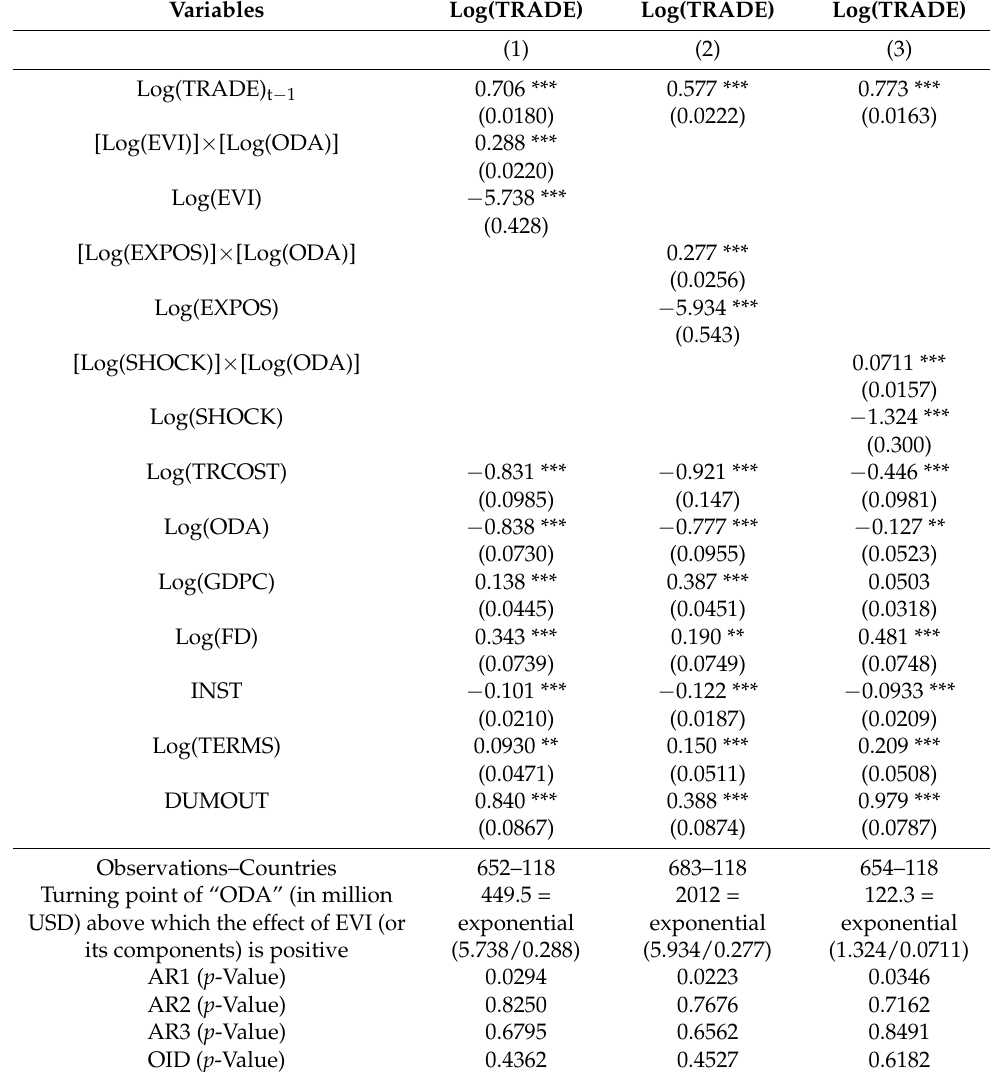
Table 5. Effect of EVI on participation in international trade for varying amounts of development aid. Estimator : Two-step System